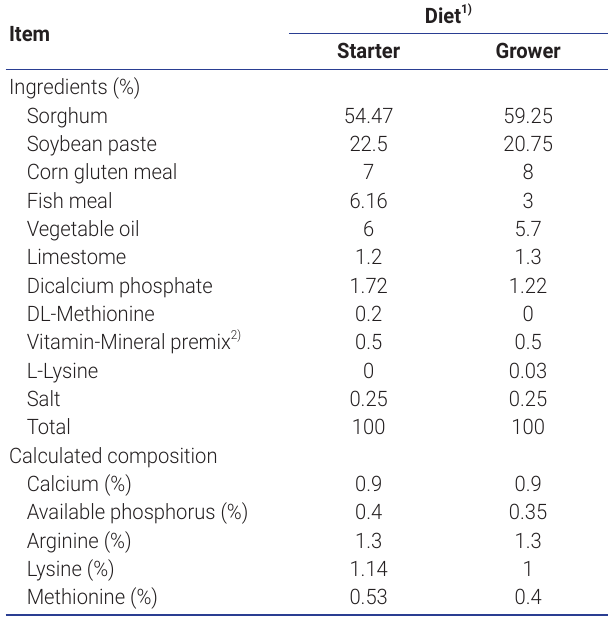
Table 1. Ingredients and composition of the basal